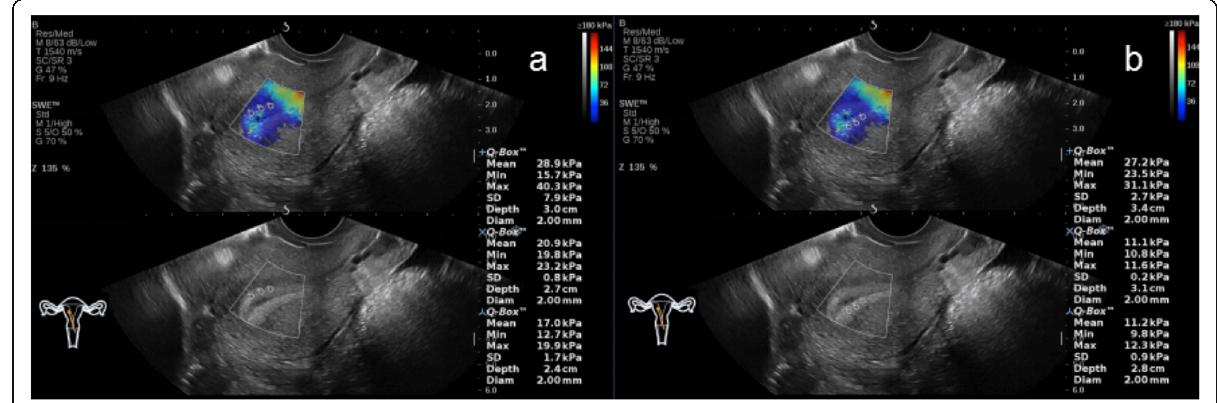
Fig. 5 Representative images of a woman in the ATAA group. a Young ’ s modulus at the three sites of the anterior endometrial wall was 28.9, 20.9, and 17.0 kPa, respectively; b Young ’ s modulus at the three sites of the posterior endometrial wall was 27.2, 11.1, and 11.2 kPa, respectively. The mean Young ’ s modulus of the six sampling sites was 19.4